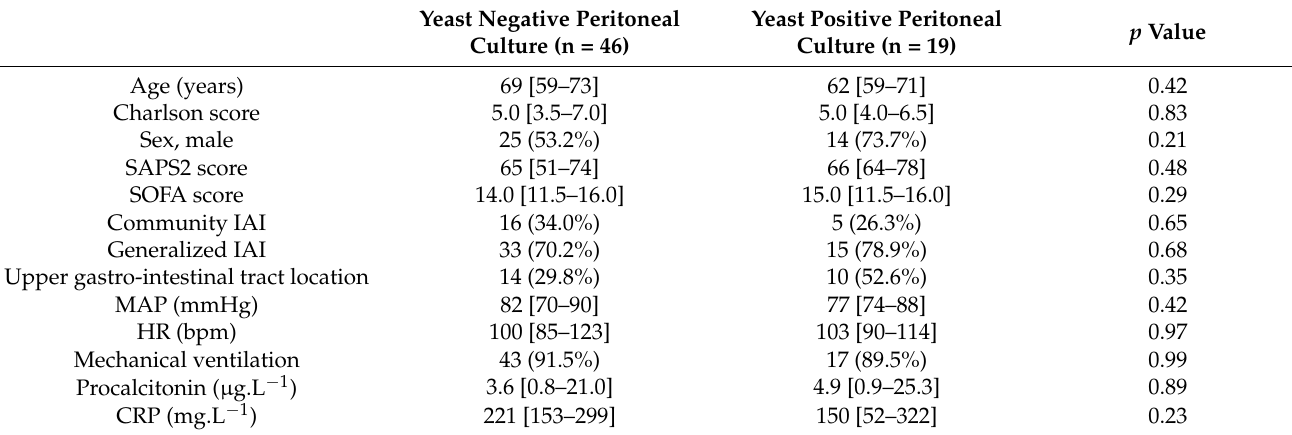
Table 1. Main characteristics of the study population according to peritoneal fluid yeast culture result.